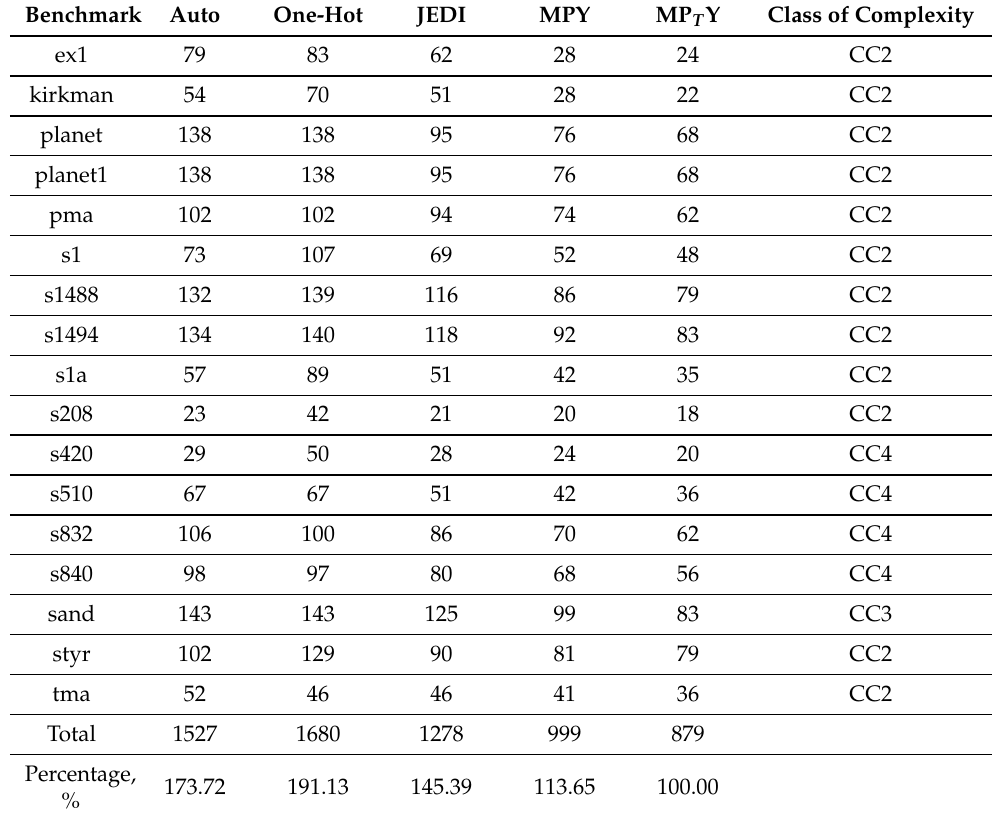
Table 9. Experimental results (the LUT counts for classes CC2-CC4).